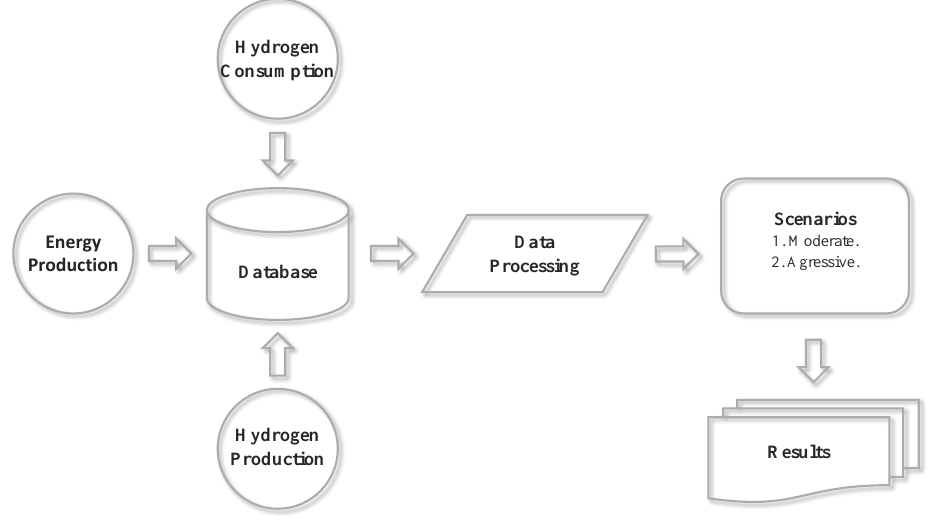
Figure 3. Diagram of the adopted